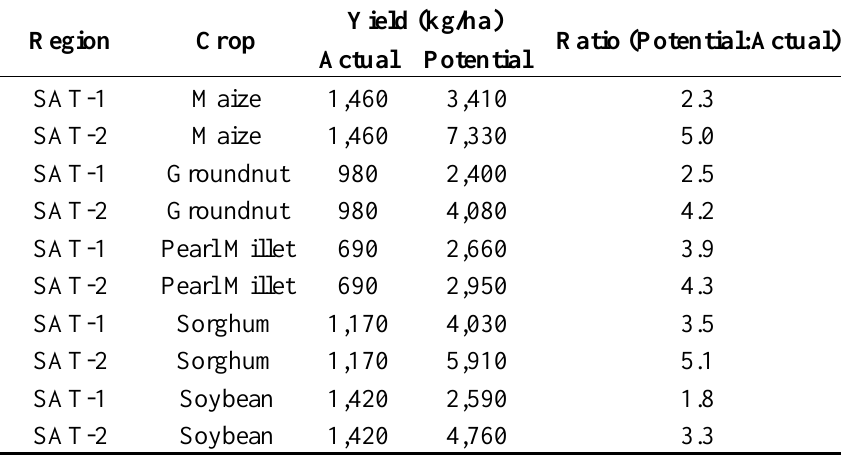
Table 8. Actual and potential yields of different crops of the semi-arid tropics (SAT) climates (adapted from